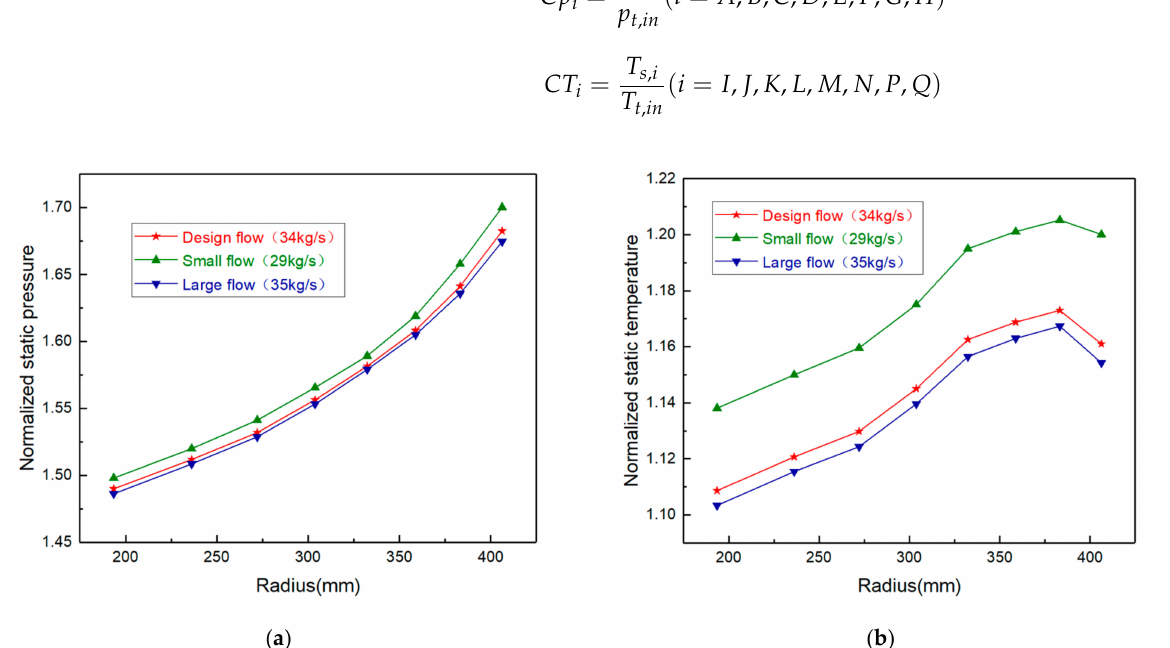
Figure 5. Distributions of aerodynamic parameters on the static wall of IBC: ( a ) static pressure distribution; ( b ) static temperature